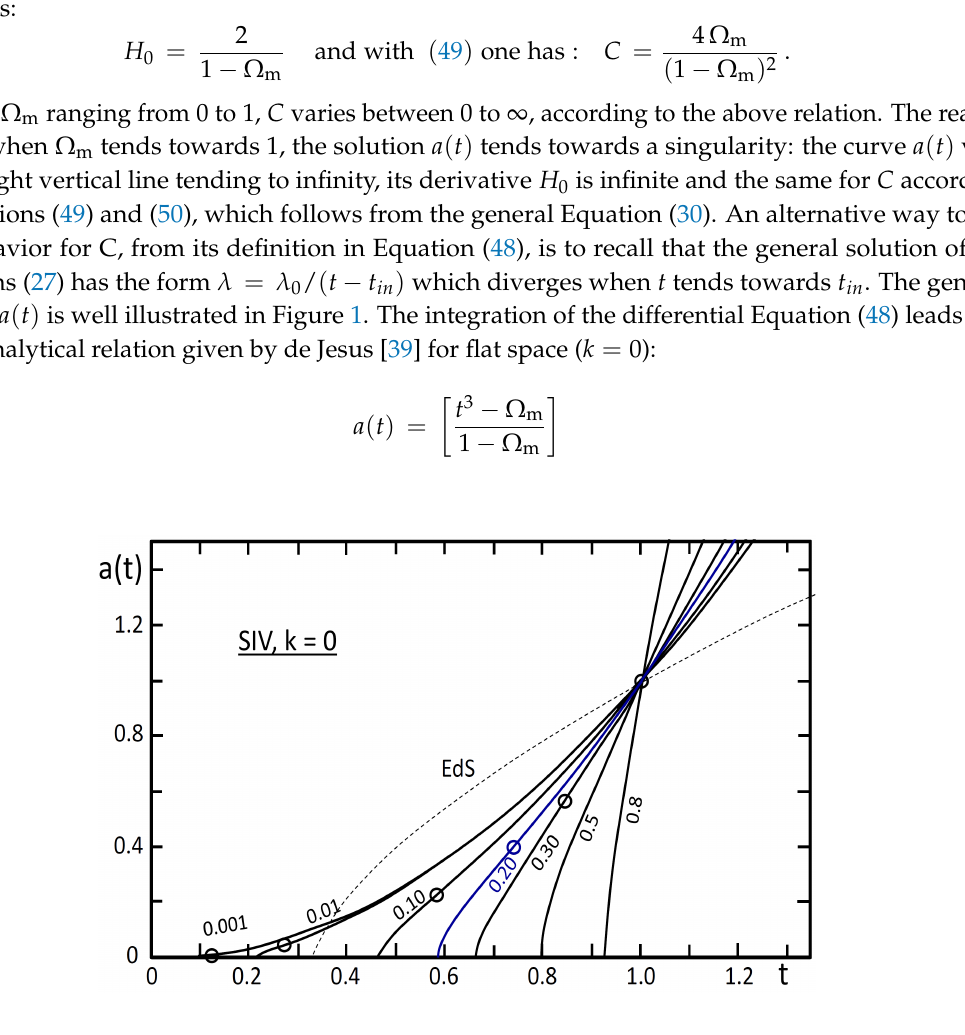
Figure 1. Some solutions of a(t) for the models with k = 0 [15]. The curves are labeled by the values of Ω m . The Einstein–de Sitter model (EdS) is indicated by a dotted line. The small circles on the curves show the transition point between braking ( q > 0 ) and acceleration ( q < 0 ) . For Ω m = 0.80, this point is at a = 2.52. The blue curve corresponds to Ω m =